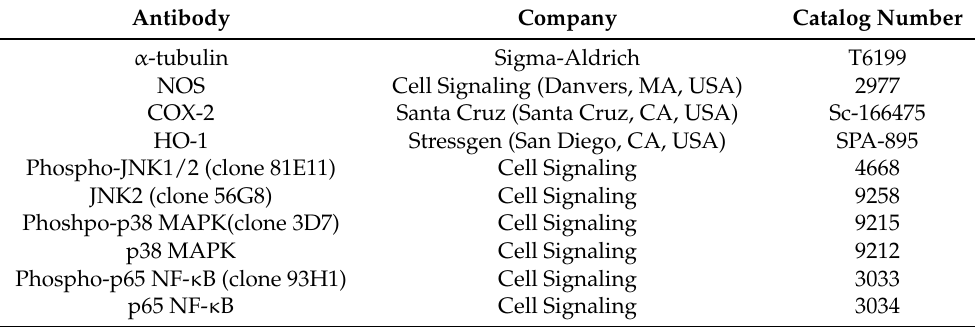
Table 1. Primary antibodies used in Western blotting.